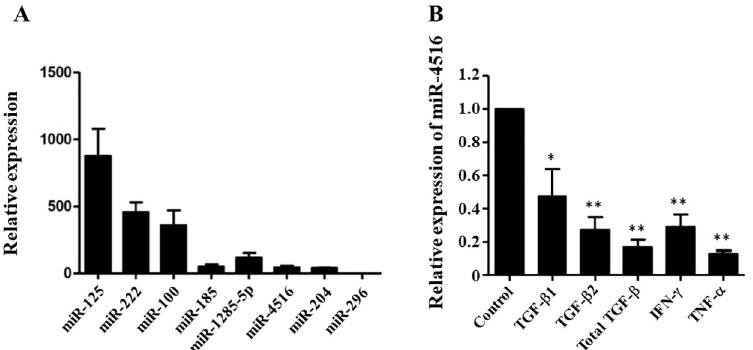
Fig 1. Expression of miR-4516 was suppressed by TGF- β 2. (A) Expression of miR-4516 and others in ARPE-19 cells. (B) MiR-4516 expression in ARPE-19 cells treated with or without transforming growth factor (TGF)- β 1, TGF- β 2, total TGF- β , IFN- γ , and TNF- α (10 ng/mL) for 24 hours. The expression levels of miR-4516 were normalized to those of the control, U6 small nuclear RNA. Data are presented as the means ± standard errors of the mean of three replicates. � p < 0.05; �� p <